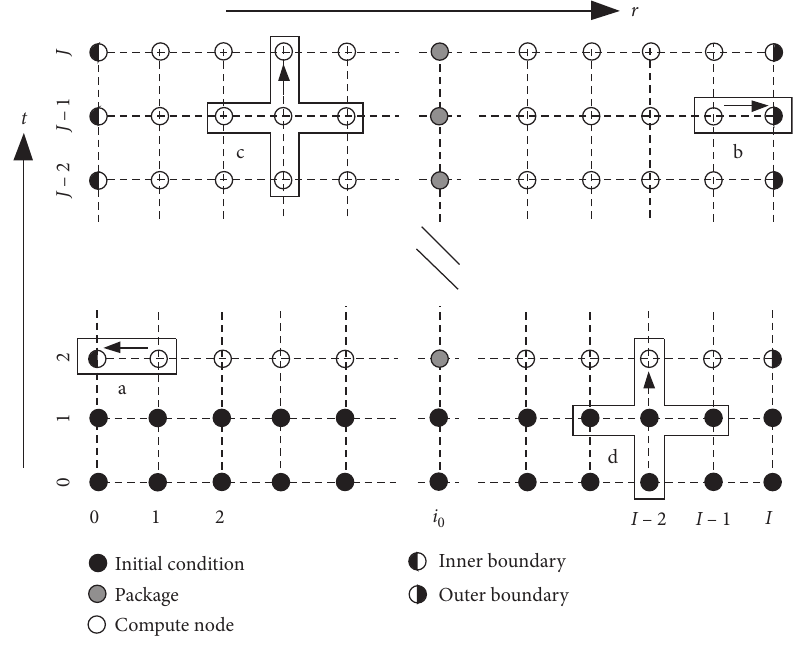
Figure 6: Difference grid. Table 1: Theoretical and existing values in the reference.